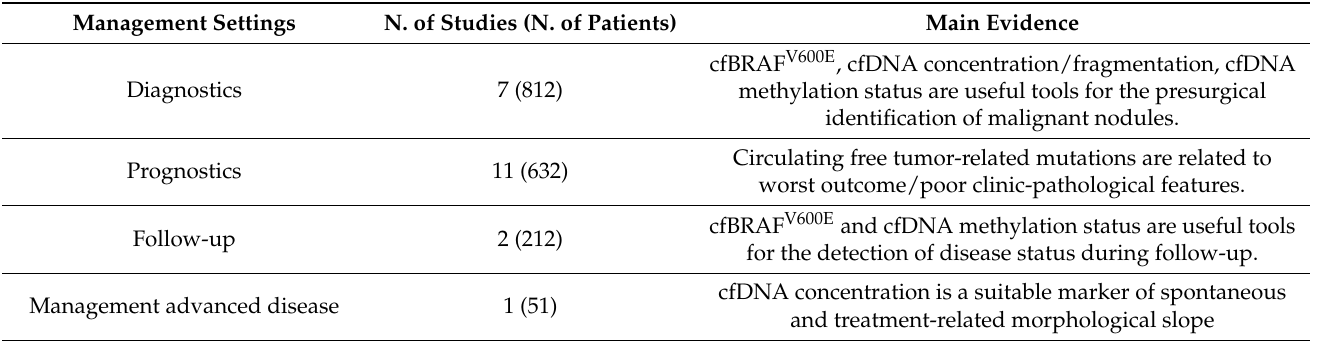
Table 4. Summary of